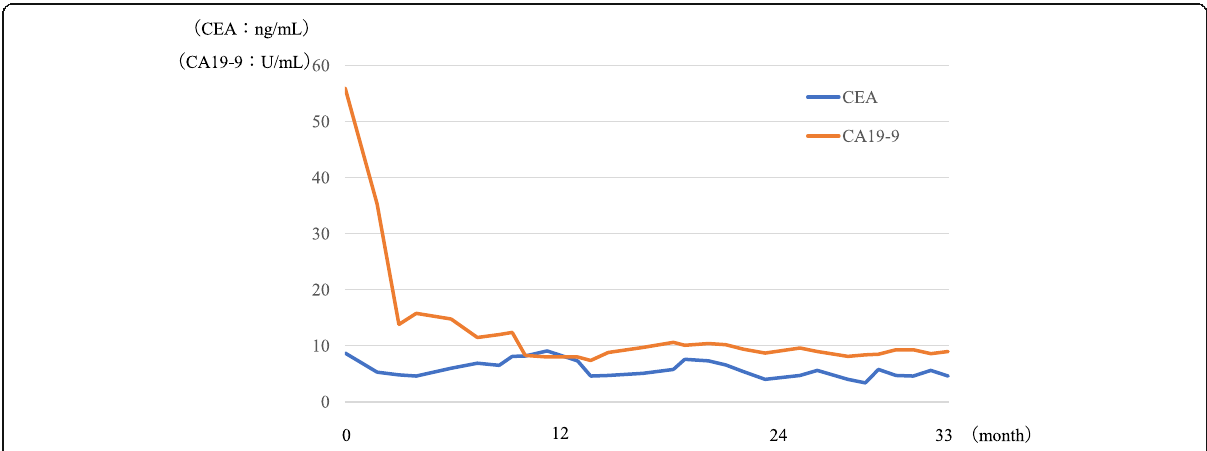
Fig. 4 Transition of tumor markers. Serum CEA and CA19-9 levels returned to normal after the start of chemotherapy. CEA, carcinoembryonic antigen; CA19-9, carbohydrate antigen